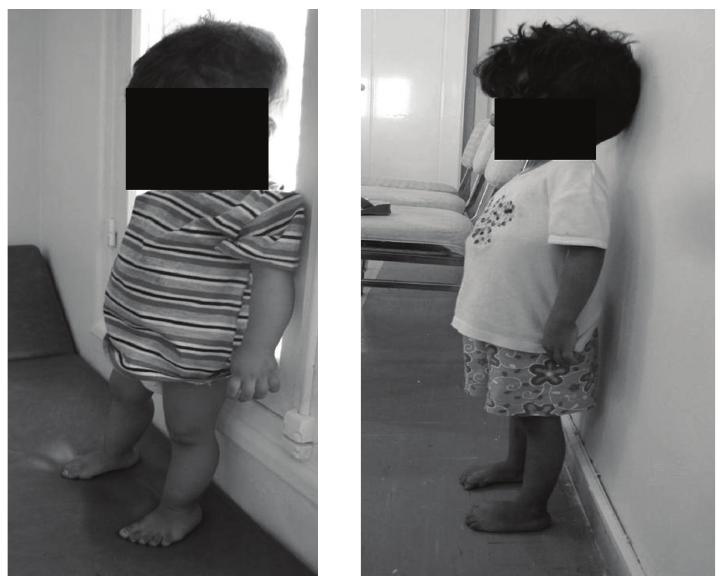
Figure 1: The short stature is evident for the two girls.